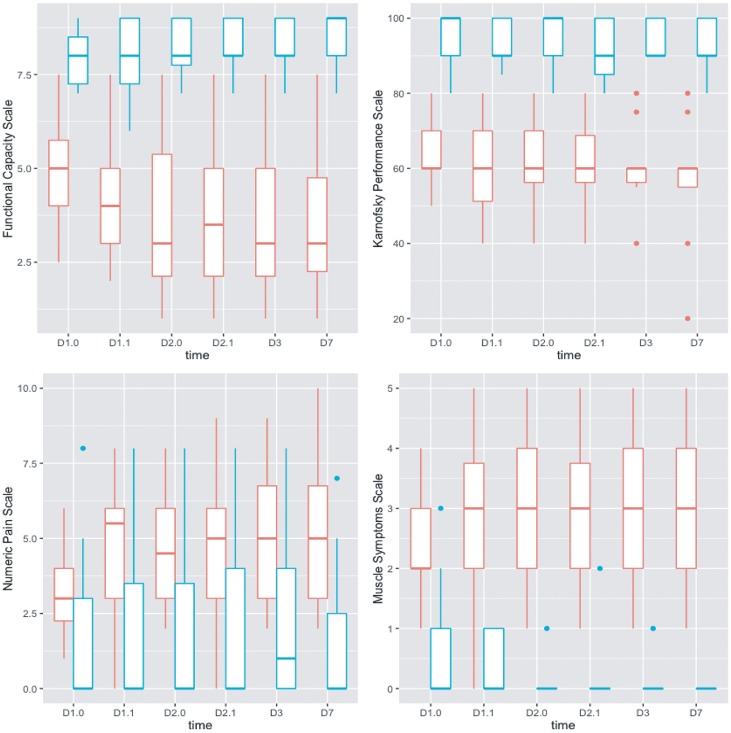
Change of numeric scales for functional scores, Karnofsky performance, pain and muscle symptoms over time.CFS patients = red, matched controls = green. D1.0 and D2.0 indicate pre-exercise assessments on day 1 and day 2, and D1.1 and D2.1 indicate post-exercise assessments on day 1 and day 2. D3 and D7 are no-exercise follow-up results.